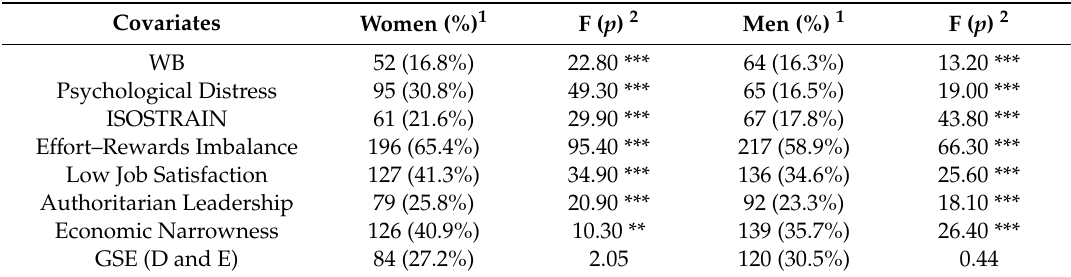
Table1. Weighteddistribution ofthefrequenciesand percentages ofexposuretoworkplace vulnerability according to